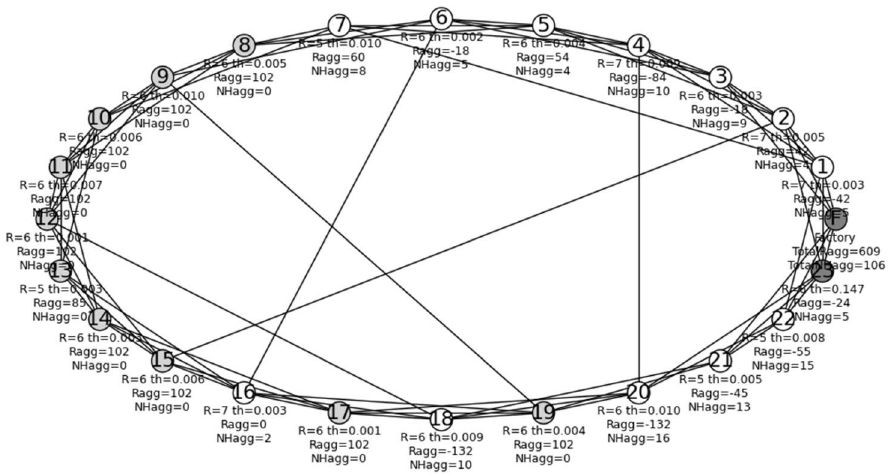
Figure 7. An example cascade failure with a blackout in a small world network. The gray color represents the electricity power plant (F) and a powered node, the white color represents node malfunction while the light gray represents power shortage